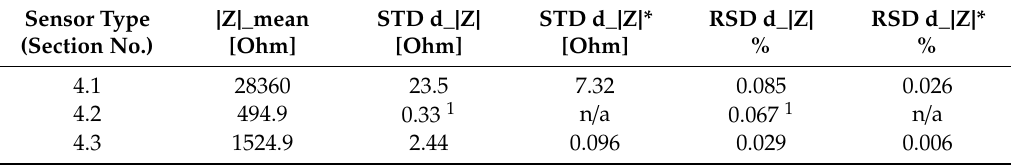
Table 1. Summary of impedance magnitude measurement results with different sensors.